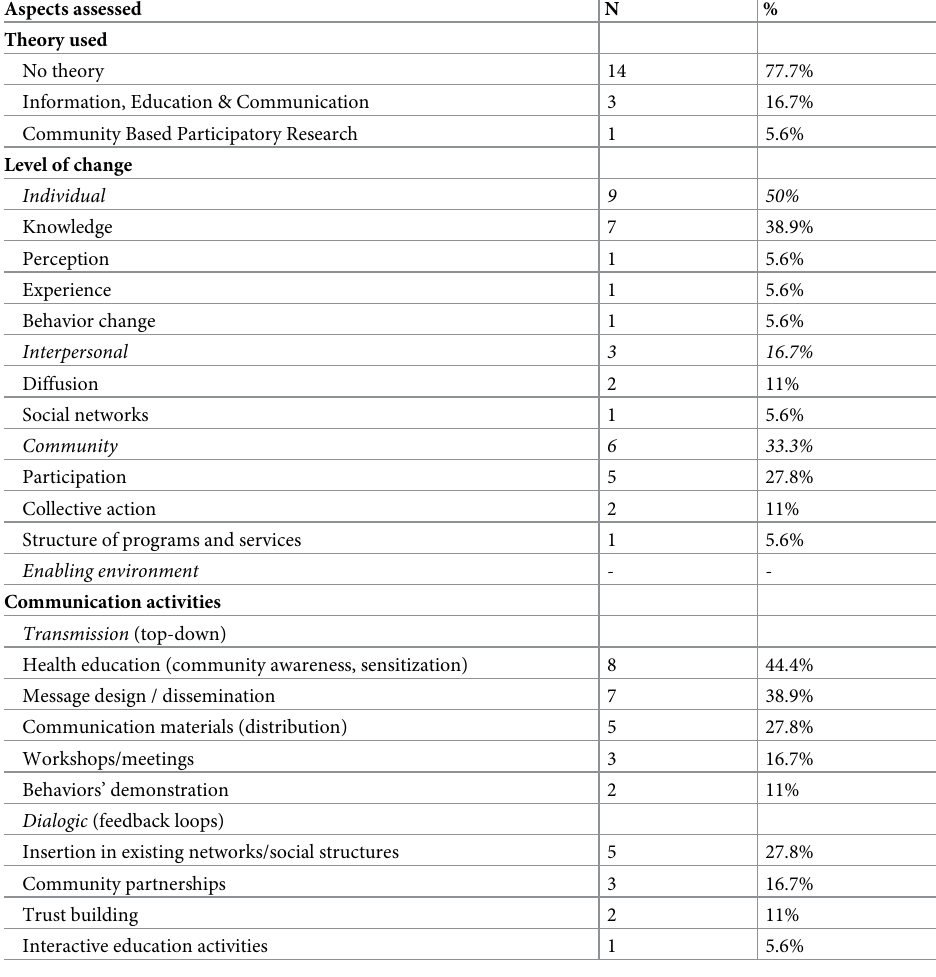
Table 1. Simplified summary of findings of communication approaches in lymphatic filariasis’ manuscripts (n = 18). Aspects assessed N Theory